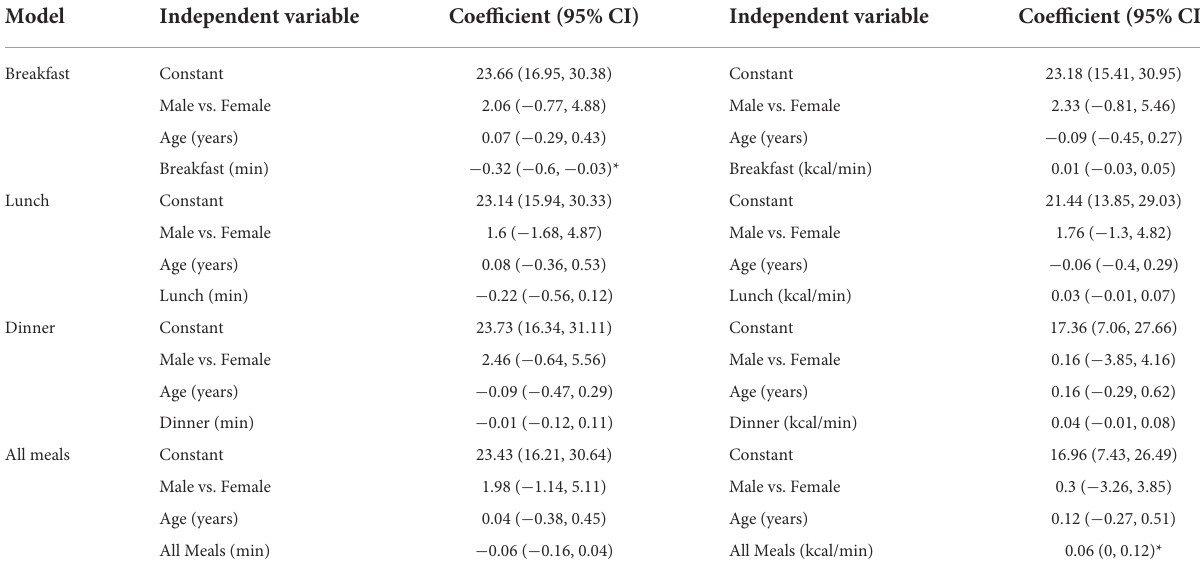
BMI and rate of